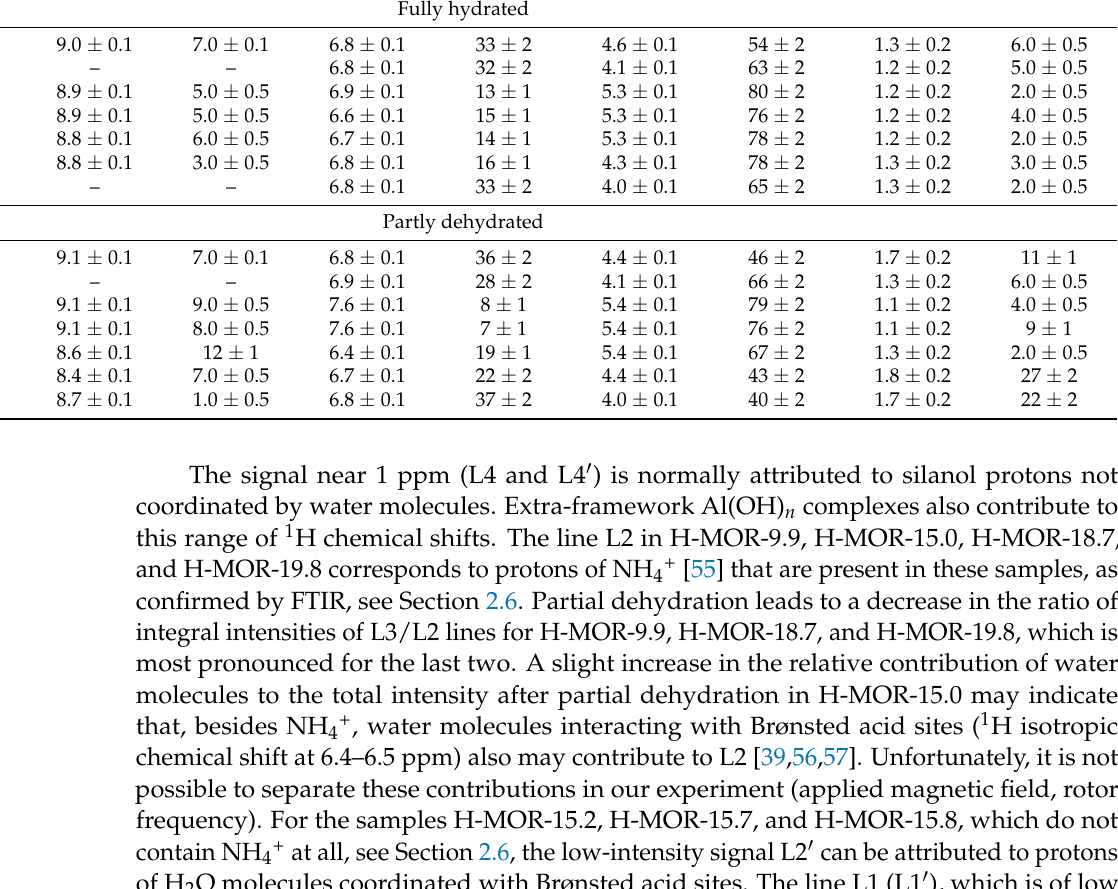
Table 4. Isotropic chemical shifts of individual 1 H MAS NMR spectral lines ( δ iso ) and their relative intensities ( I ) for fully hydrated and partly dehydrated samples; ν rot = 15 kHz.